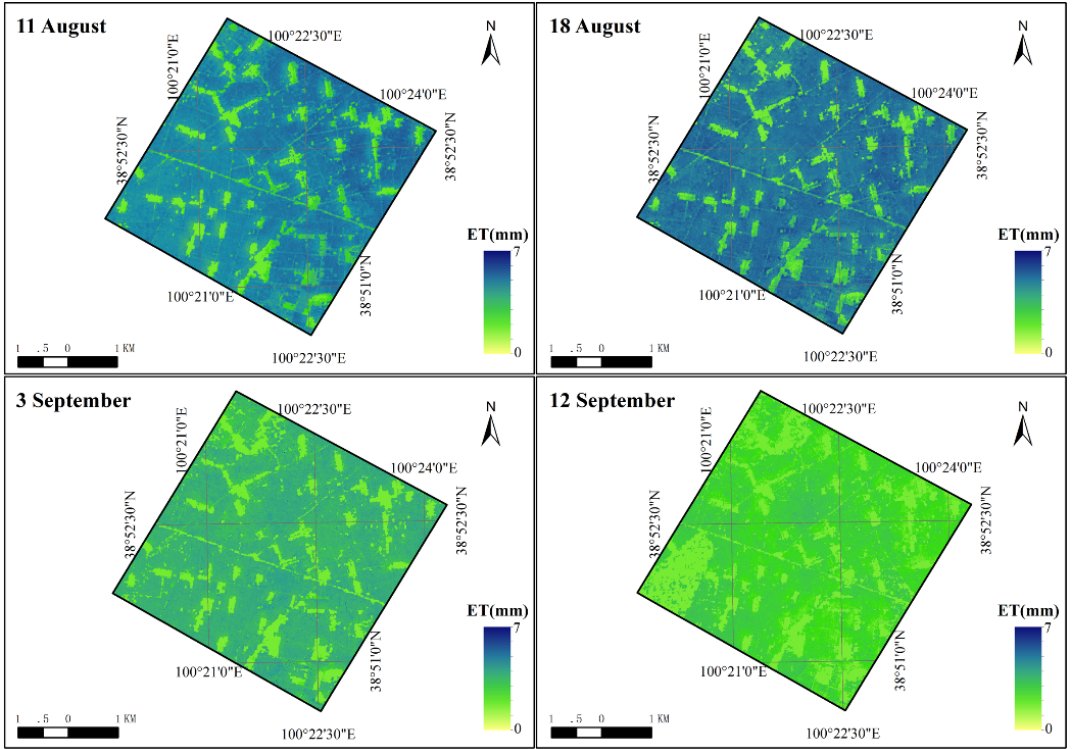
Figure 8. Comparison of the daily ET derived from the improved and original TSEB with EC tower-based measurements.